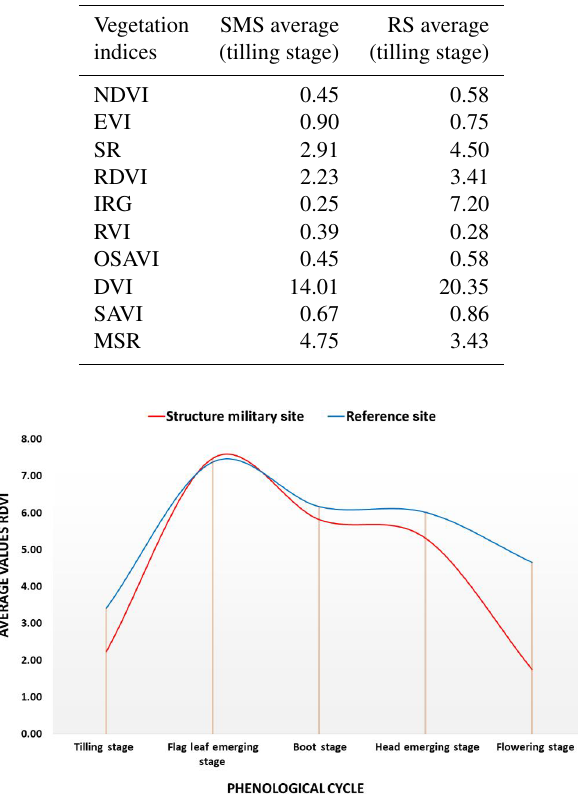
Figure 7. Same as Fig. 5, but for SR.